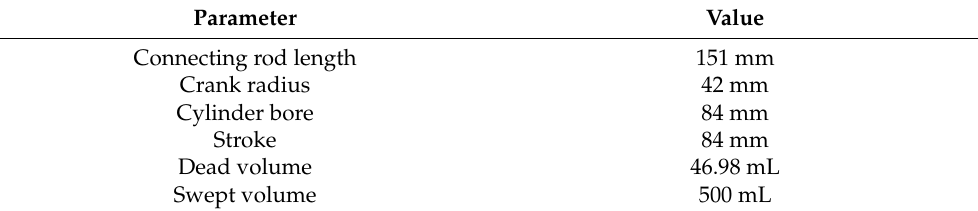
Table 1. Engine main